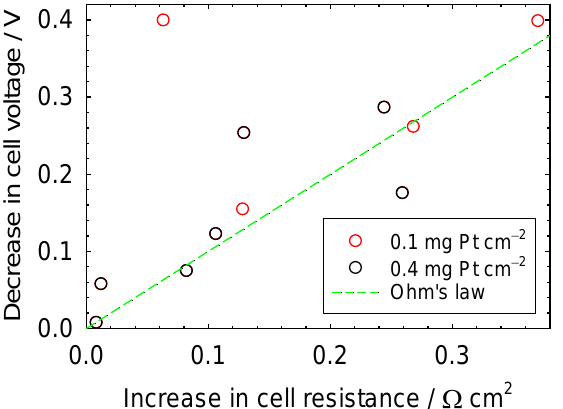
Figure 5. Cell voltage loss as a function of the sum of the changes in kinetic and mass transfer resistance.